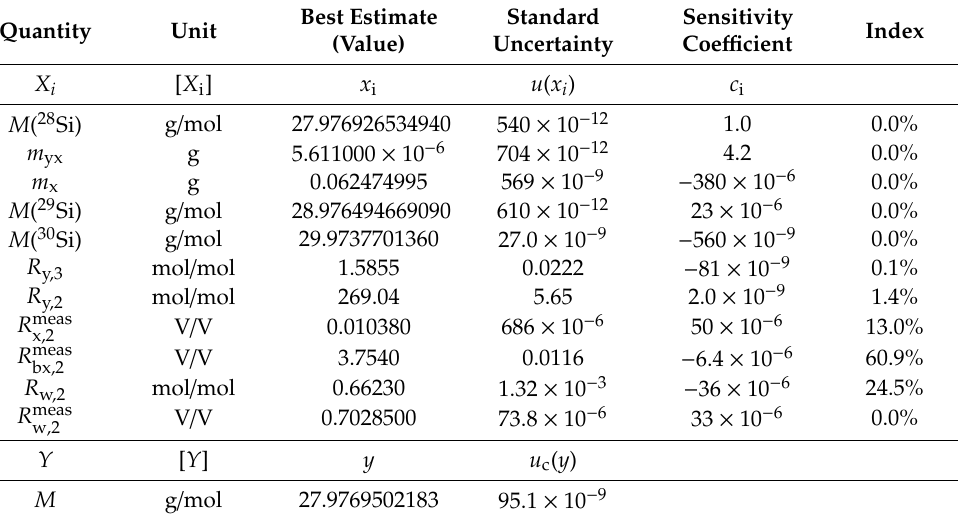
Table 3. Representative uncertainty budget of sample N.2.1 (single measurement).